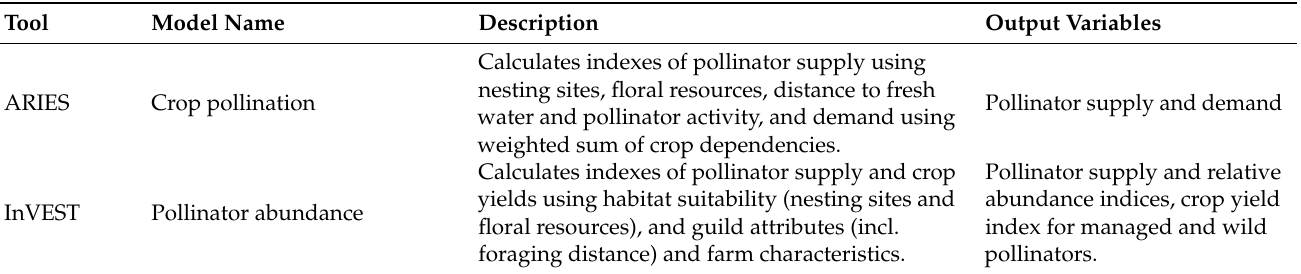
Table 8. Summary of the shortlisted tools and associated models that quantify crop